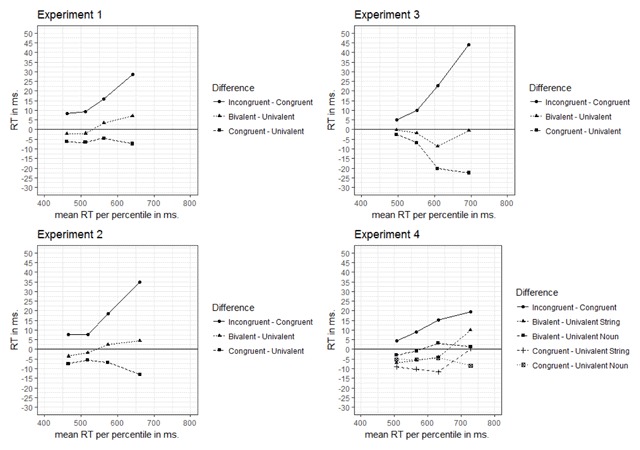
RT difference scores for the 20th, 40th, 60th and 80th percentile, between incongruent and congruent stimuli, congruent and univalent stimuli, and univalent and bivalent stimuli. X-axis values are the mean RTs across congruent, incongruent, and univalent stimuli per percentile.